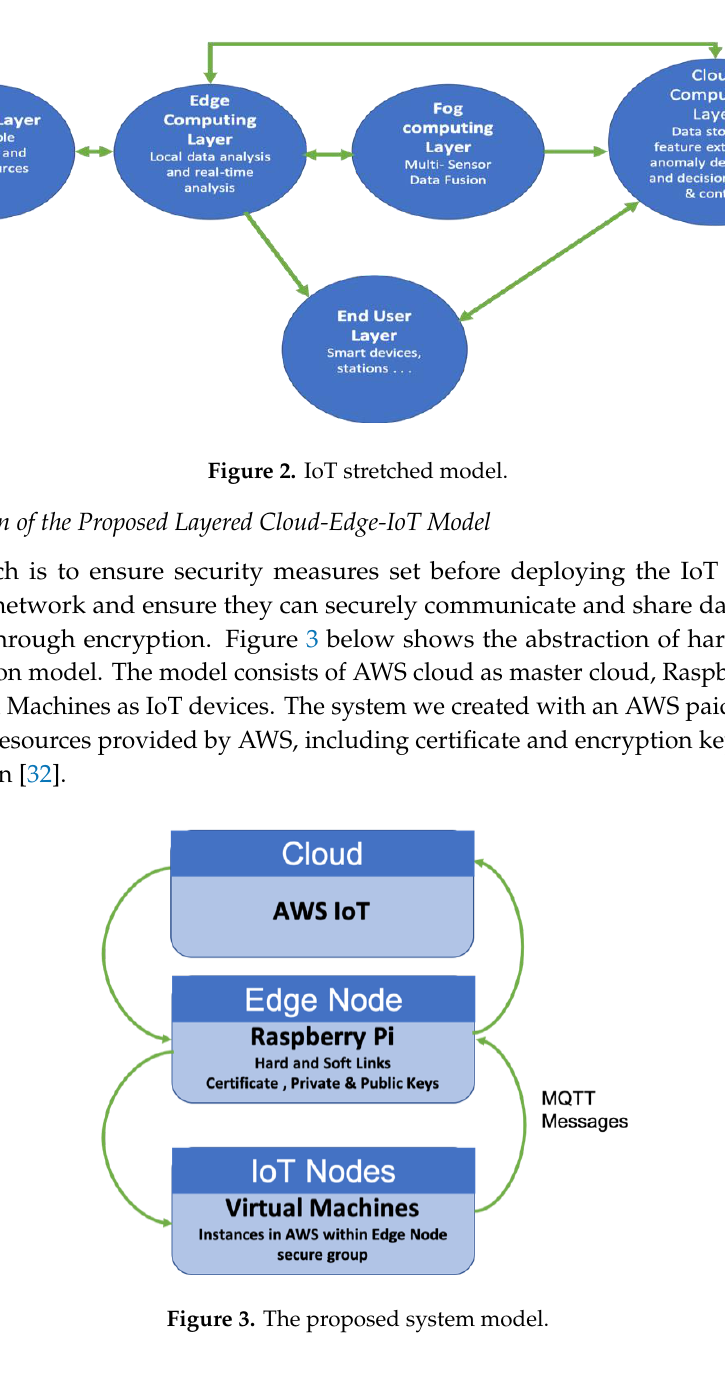
Figure 1. Internet of Things (IoT) generic model with privacy and security policies.